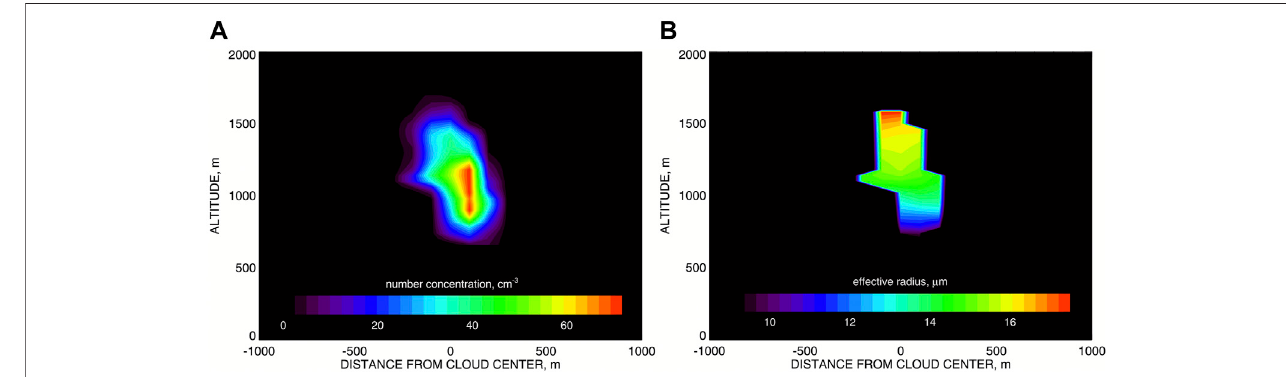
FIGURE 2 | (A) droplet number concentration fi eld in the 2D cross section of the LES-generated Cu cloud to be used in this study. (B) same as (A) but for the effective radius of the droplet size distribution. The plot is restricted to the area with N c ≥ 10 cm − 3 .